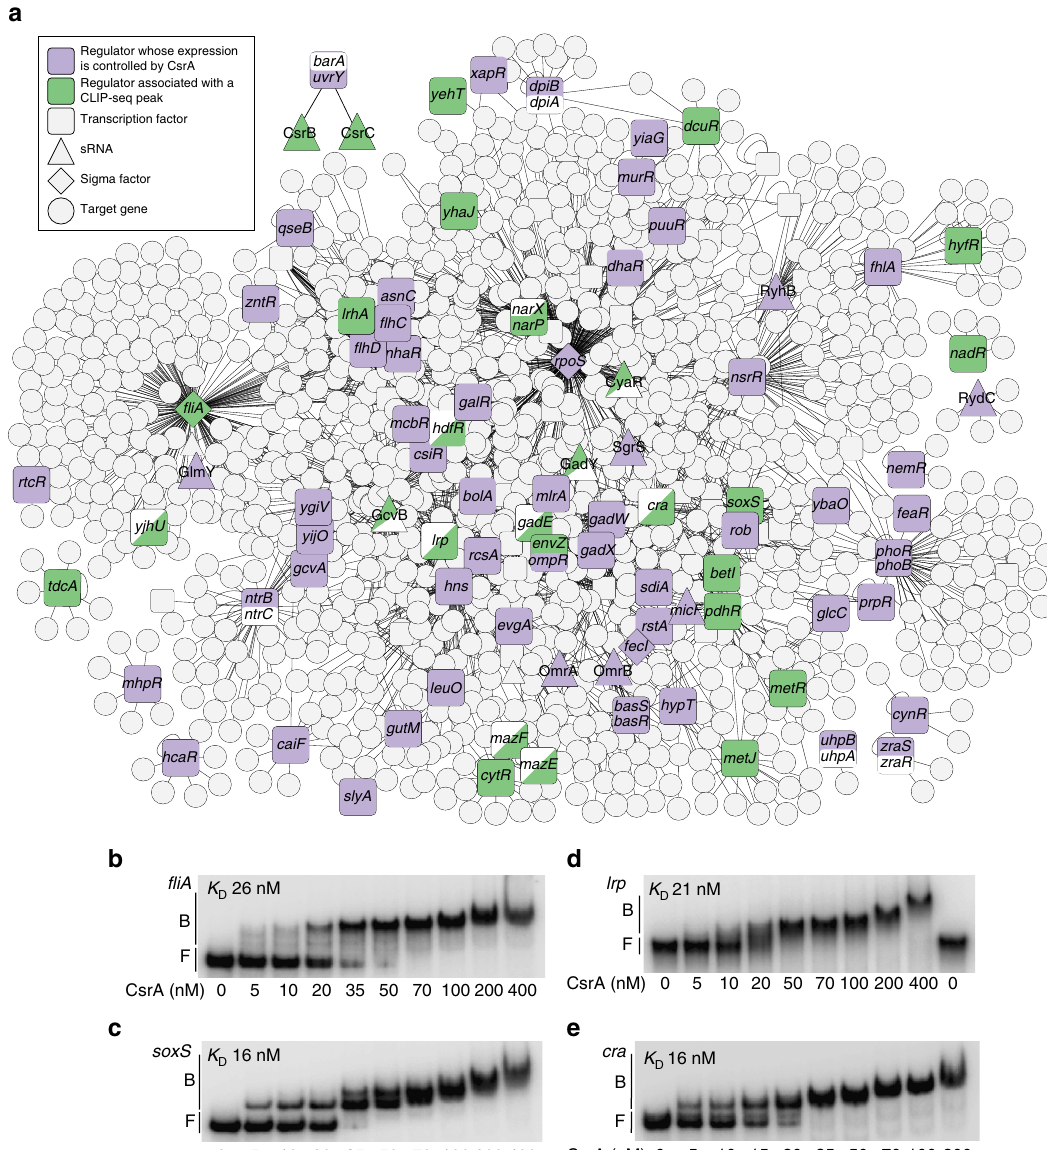
Fig. 7 Integration of CsrA into E . coli regulatory networks. a Transcriptional regulators, two-component regulatory system (TCS) sensor kinases, and sRNAs that were differentially expressed in the csrA mutant and their target genes are shown. E . coli transcriptional and sRNA regulatory networks were extracted from RegulonDB 4 . Regulators associated with CLIP-seq peaks and differentially expressed are shown in green and those differentially expressed without an associated CLIP-seq peak are in purple. Those with CLIP-seq peaks that were not differentially expressed are shown in green and white. Regulators represented as squares are transcription factors, triangles are sRNAs, and diamonds are sigma factors. Sensor kinases that were differentially expressed are shown together with their cognate response regulators. b – e Electrophoretic mobility shift assays (EMSA) showing interaction of CsrA with transcripts of regulatory genes: b fl iA ( − 30 to +165 nt relative to the start codon). c soxS ( − 40 to +87 relative to the start codon), d lrp ( − 318 to +45nt relative to the start codon). e cra ( − 81 to +222 nt relative to the start